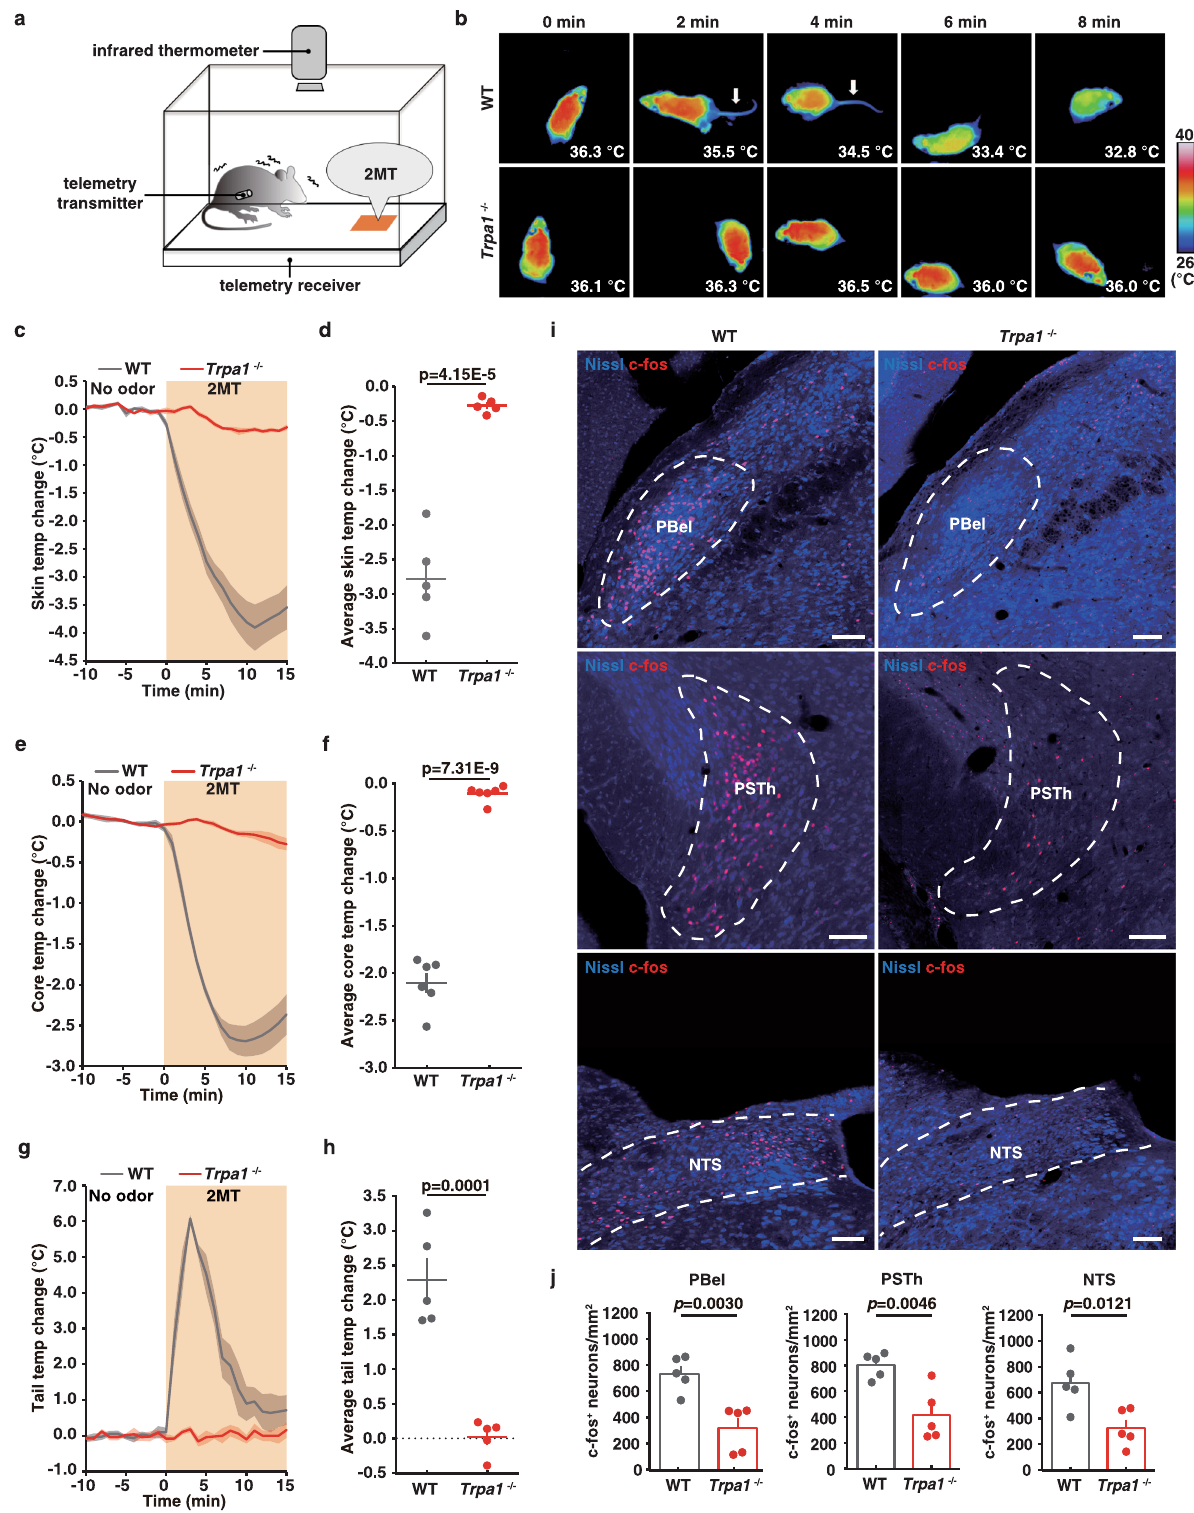
Fig. 1 Innate fear odor 2MT induces hypothermia and tail temperature increase via Trpa1. a Schematic of 2MT-induced hypothermia assay in mice. b Time-lapsed thermal images showing tail and skin temperature changes in wild-type (upper) and Trpa1 − / − (bottom) mice during 2MT treatment. Skin ( c ), core ( e ) and tail ( g ) temperature curves of wild-type and Trpa1 − / − mice ( n = 5 or 6) before and during 2MT treatment. Average skin ( d ), core ( f ) and tail ( h ) temperature changes of wild-type and Trpa1 − / − mice ( n = 5 or 6) during 2MT treatment. i Representative images showing 2MT-induced c-Fos expression in PBel, PSTh, and NTS of wild-type and Trpa1 − / − mice. j Quantitative analysis of 2MT-evoked c-Fos expression in PBel, PSTh, and NTS in wild- type and Trpa1 − / − mice ( n = 5). c – h , j Data are mean ± SEM; two-side Student ’ s t test. Scale bars, 100 µ m.